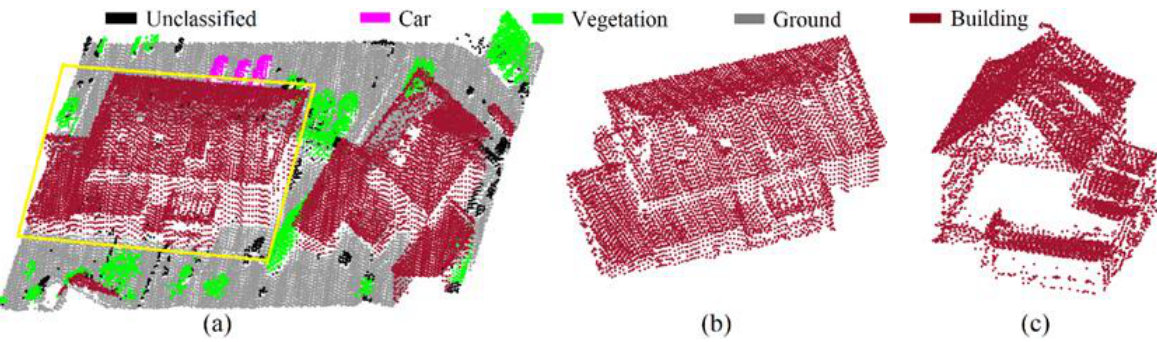
Figure 3 . (a) Labelled Dudelange, Luxembourg data, (b) front-view of the building within the yellow box in plot (a) to extract footprint, (c) side-view of the